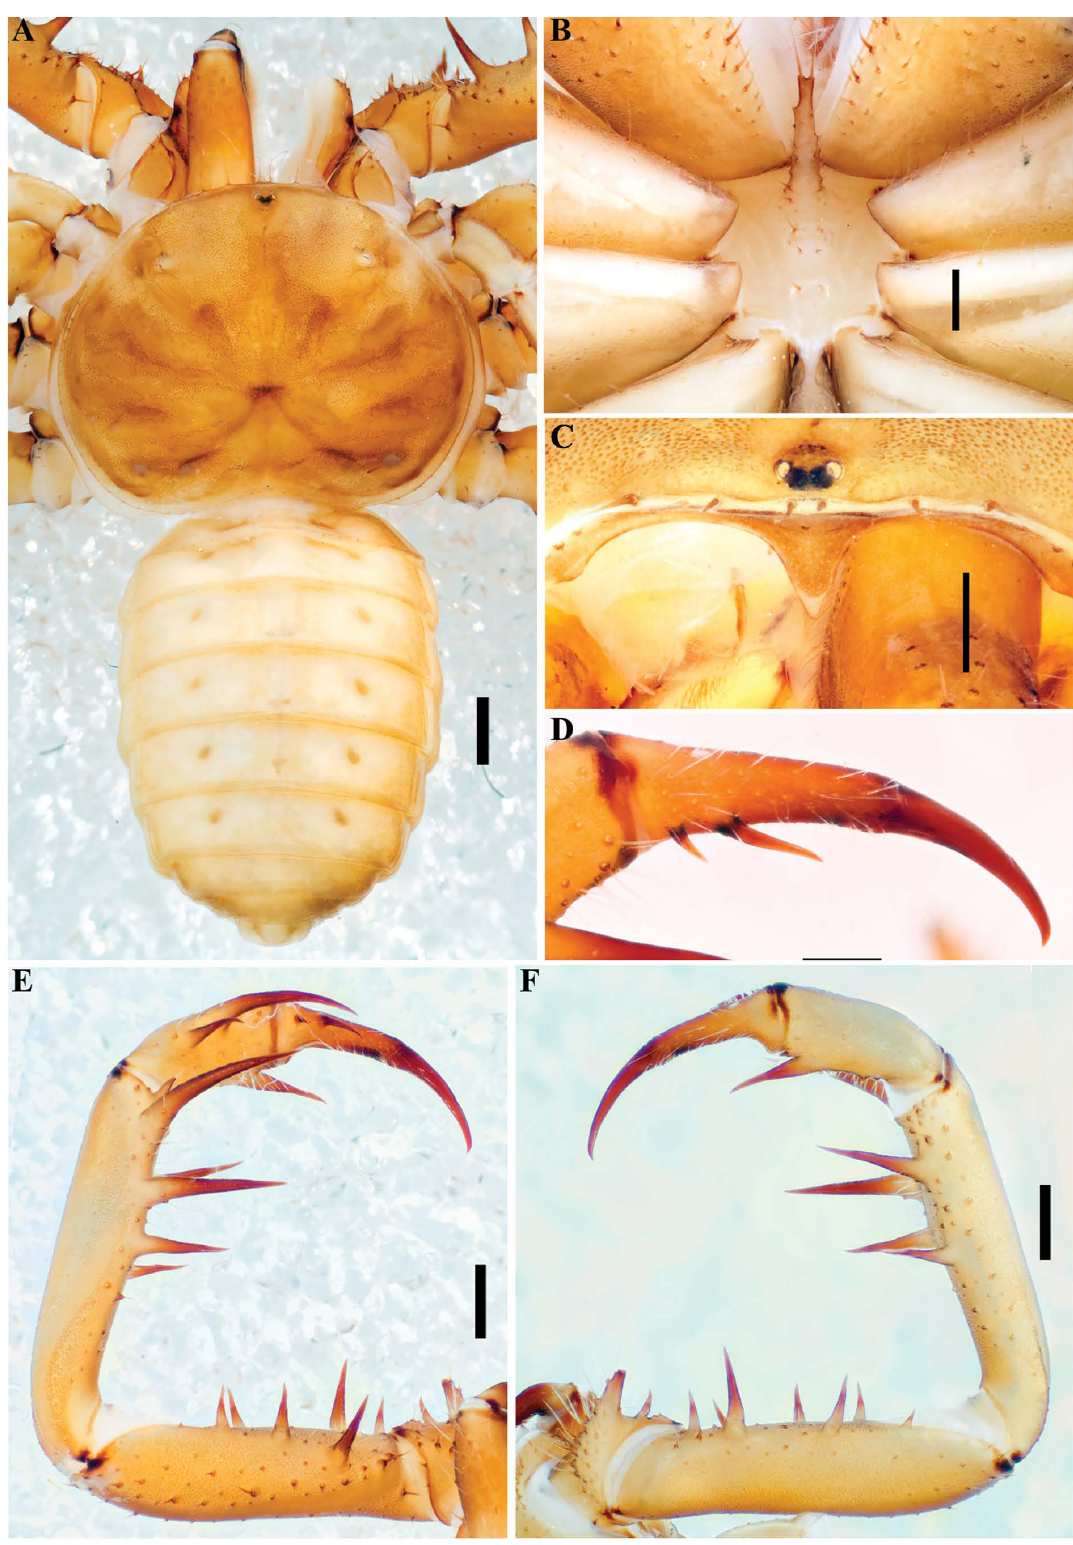
Fig. 99. Charinus longipes Weygoldt, 2006 (MNHN), general morphology, ♀. A . Habitus, dorsal view. B . Sternum, ventral view. C . Frontal process. D . Pedipalp tarsus, frontal view. E . Pedipalp, dorsal view. F . Pedipalp, ventral view. Scale bars: A, E–F = 1 mm; B–D =